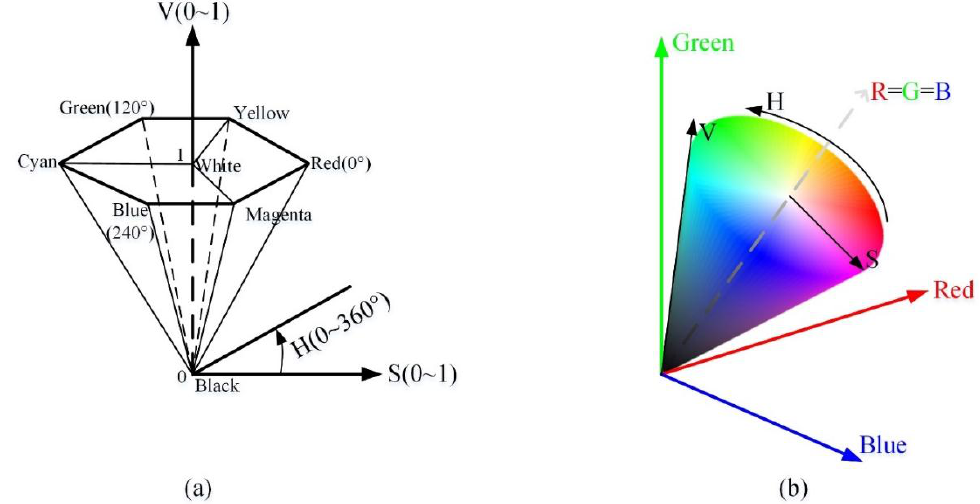
Figure 3. The HSV color space about ( a ) H, S, and V components; ( b ) the geometric relationship of transformation from RGB to HSV. The reflectance at red, green, and blue bands of remote sensing images are used to make the R, G, and B color composite in this study. The values of R, G, and B are between 0 and 1.